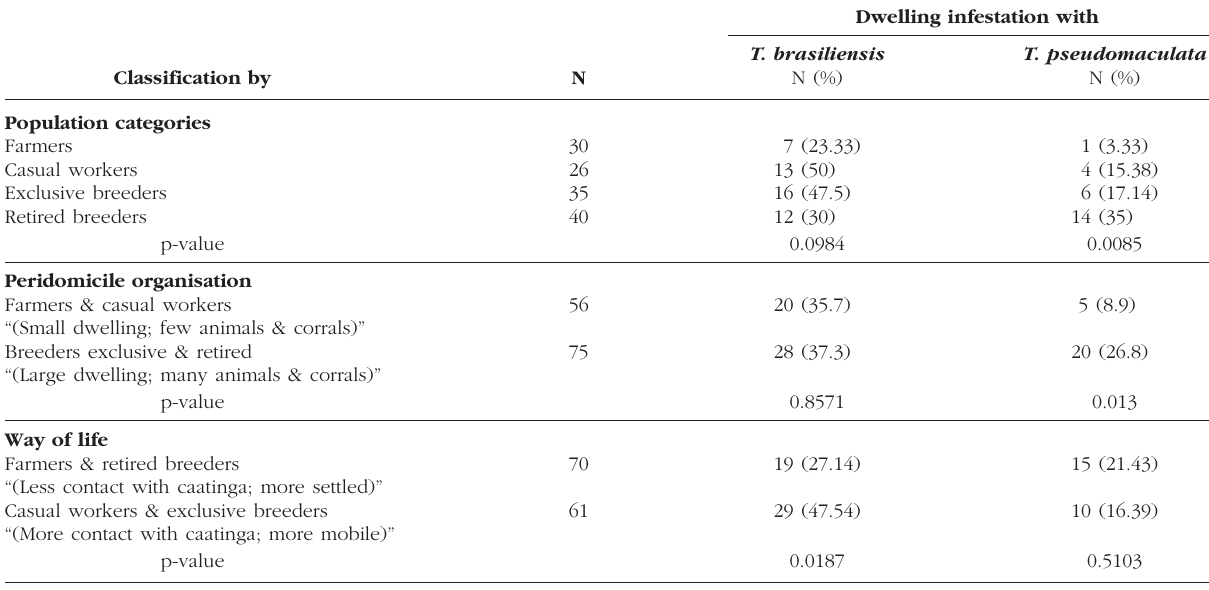
Table II. – Distribution of Triatoma species according to the population surveyed.